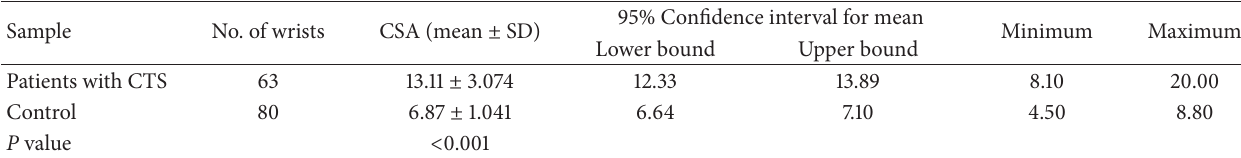
Table 2: The descriptive statistics for CSA of MNs of patients and controls at the carpal tunnel inlet. Sample